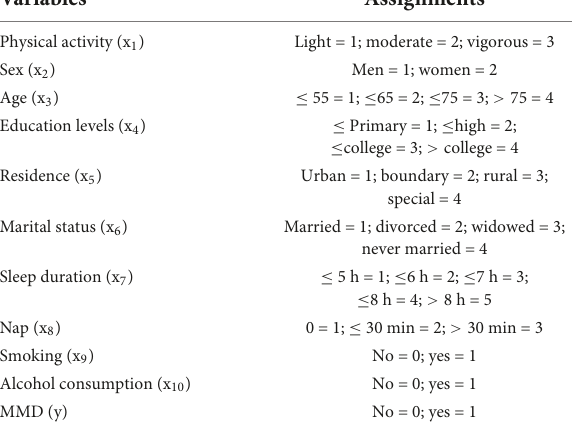
TABLE 2 Variables and their